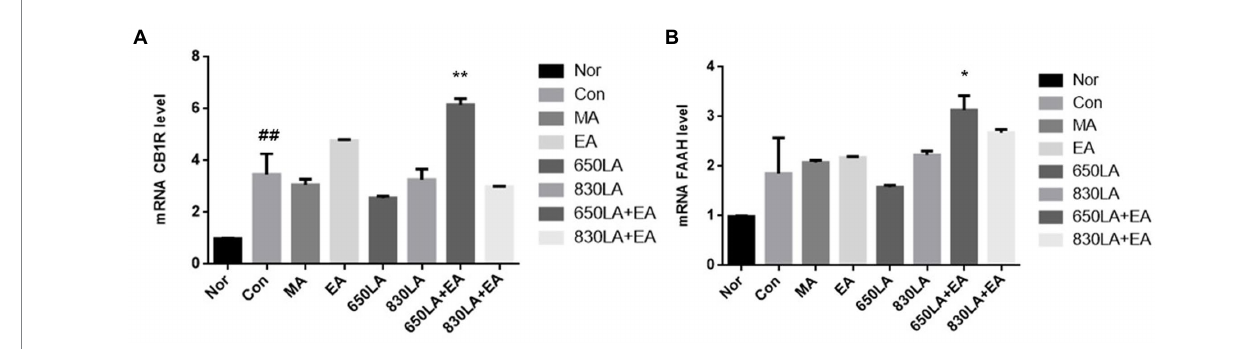
FIGURE 2 mRNA expression of CB1R and FAAH in rats with paclitaxel-induced allodynia according to type of acupuncture treatment. There was a significant increase in mRNA CB1R in the Con group compared to the Nor group ( p < 0.01), and a significant increase in mRNA CB1R in the 630LA + EA group compared to the control group ( p < 0.01, A ). Compared to the Nor group, the Con group had a tendency to an increase in FAAH mRNA expression and a significant increase in mRNA FAAH in the 630LA + EA group compared to the control group ( p < 0.05, B ). ## p < 0.01 compared to the normal group; * p < 0.05, compared to the control group; ** p < 0.01, compared to the control group. MA, manual acupuncture; EA, electroacupuncture; LA, laser acupuncture; Nor, normal; Con,